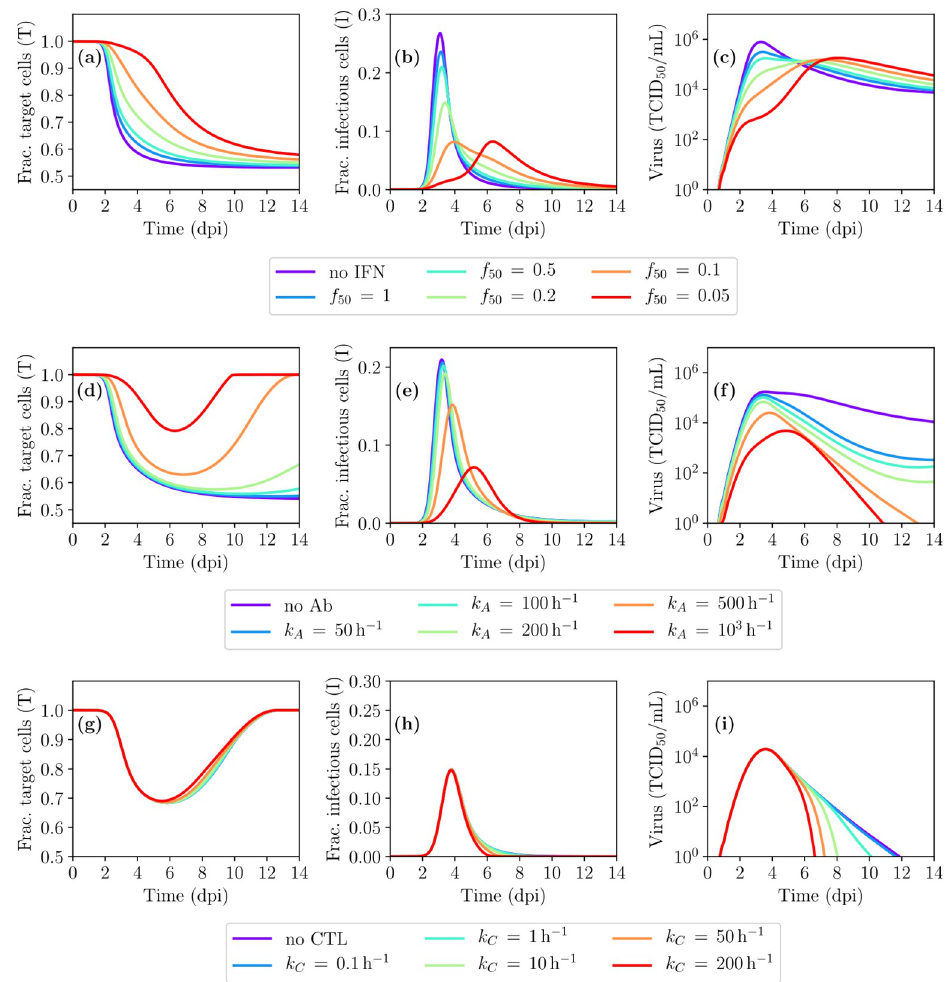
Fig 9. Spatial MM-predicted IAV infection in the presence of key immune response components. (a–c) The effect of interferon (IFN) as IFN resistance, f 50 , is decreased (sensitivity is increased). (d–f) The combined effect of IFN and antibodies (Abs) as the rate of infectious virus neutralization by Abs, k , is increased. (g–i) The combined effect of IFN A +Abs and cytotoxic T lymphocytes (CTLs) as the rate of infected cell killing by CTLs, k C , is increased. Unless otherwise noted, f 50 = 0.5 and k = 500 h − 1 A